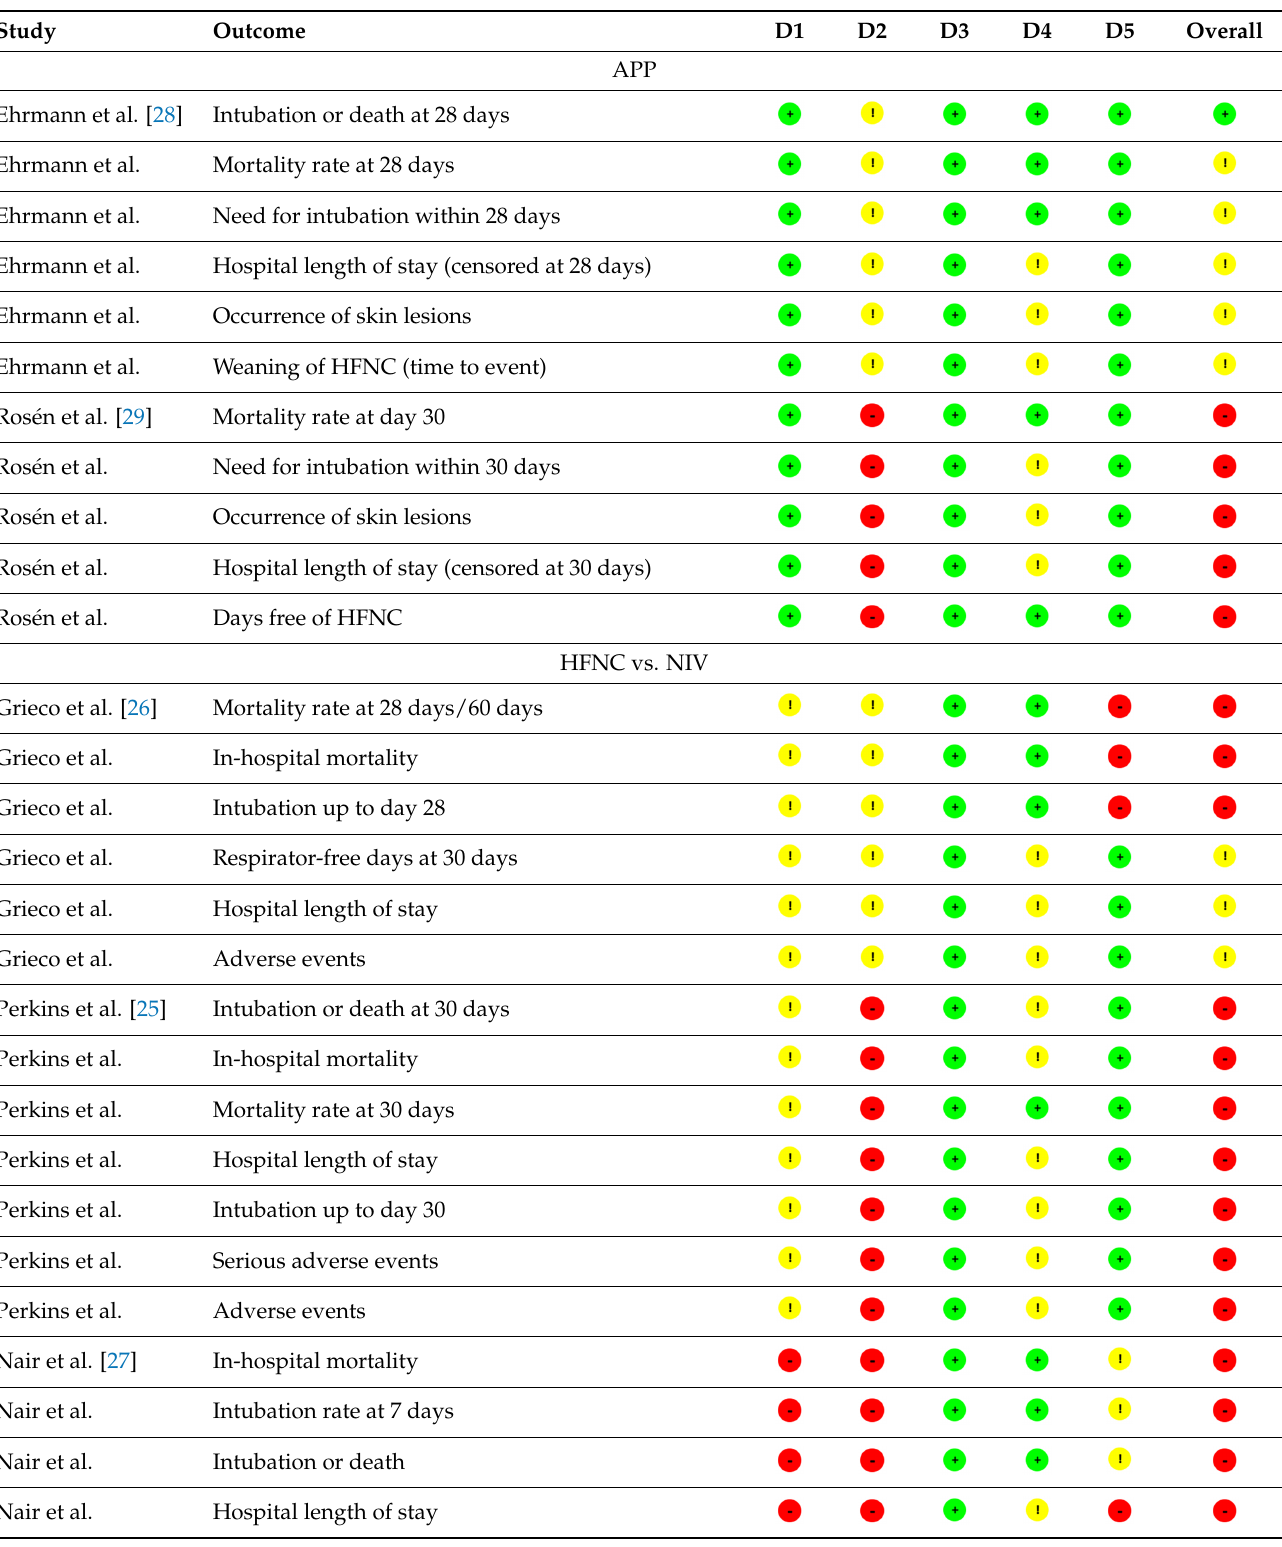
Table 2. Risk of bias assessment of the included studies per outcome. D1: randomization process, D2: deviations from the intended interventions, D3: missing outcome data, D4: measurement of the outcome, D5: selection of the reported results, HFNC high-flow nasal cannula, NIV: non-invasive ventilation.